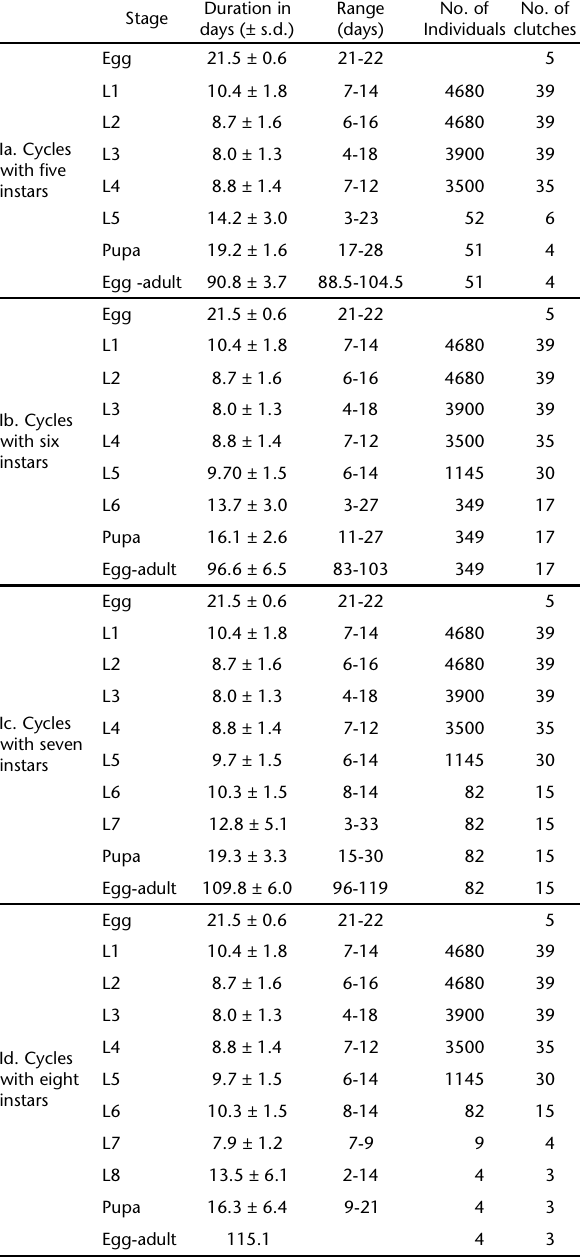
Table I. Developmental timeline of Altinote ozomene . Duration in Stage days (±